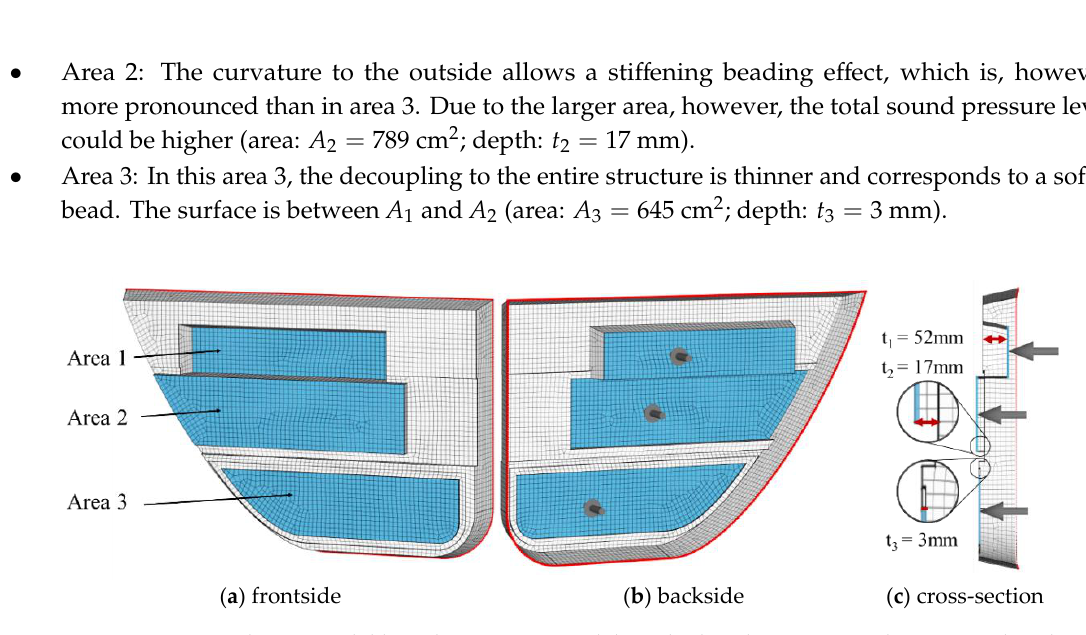
Figure 2. FE simulation model based on a CAD model meshed with CQUAD8 Elements and with fixed constraints on the free edges; ( a ) the frontside of the panel, ( b ) the backside with individual point forces, and ( c ) the cross-section with individual structure depths marked red.